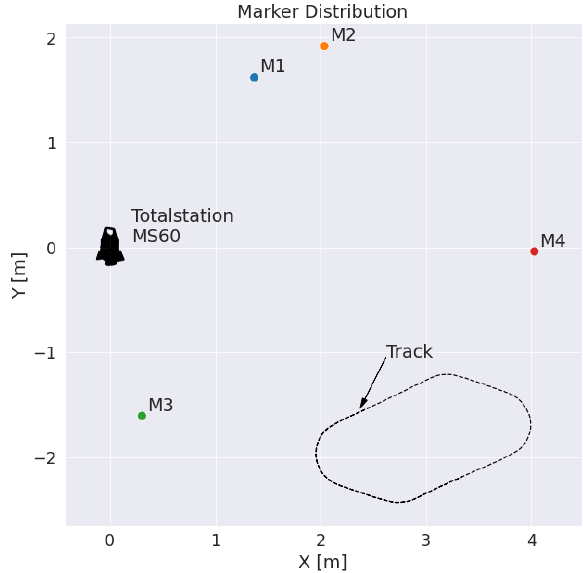
Figure 10. Marker distribution (M1 – M4) on test site for